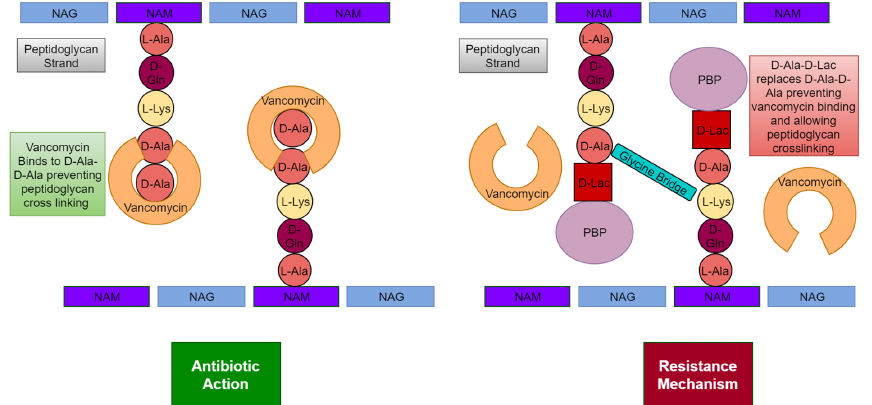
Figure 4. Antibiotic action of vancomycin against S. aureus and resistance mechanisms used by S. aureus against vancomycin. S. aureus against vancomycin.